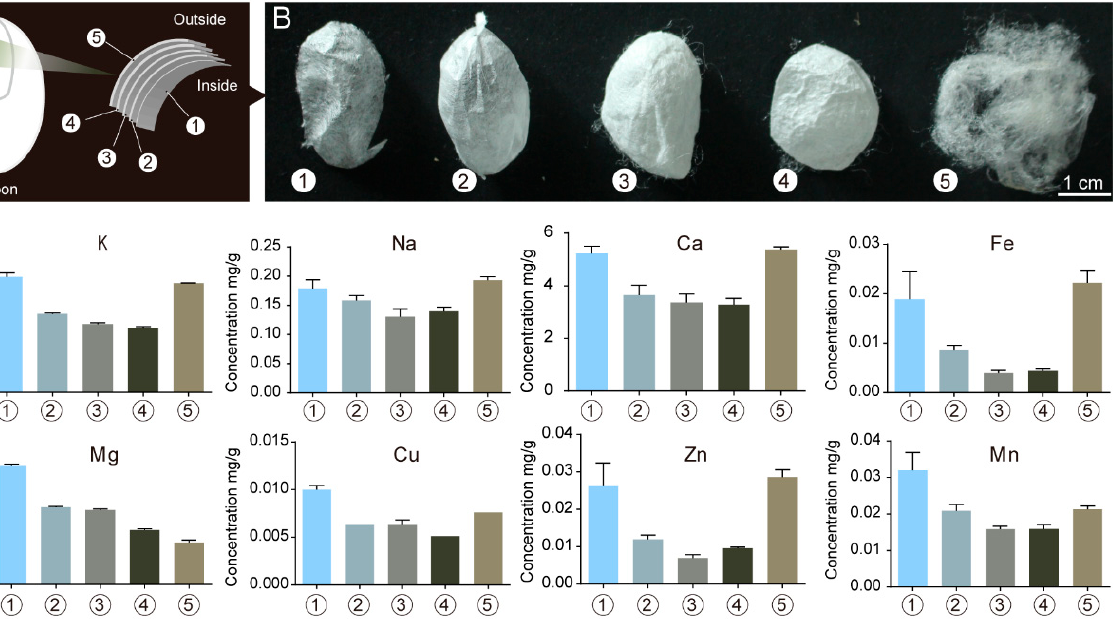
Figure 4. Content of metal elements in different cocoon layers of silkworm cocoons. (A) Schematic diagram of cocoon layers; (B) Photographs of different cocoon layers; (C) Contents of different metal elements in different cocoon layers. 1–5: From inside to outside, different cocoon layers, Error bars show SD.